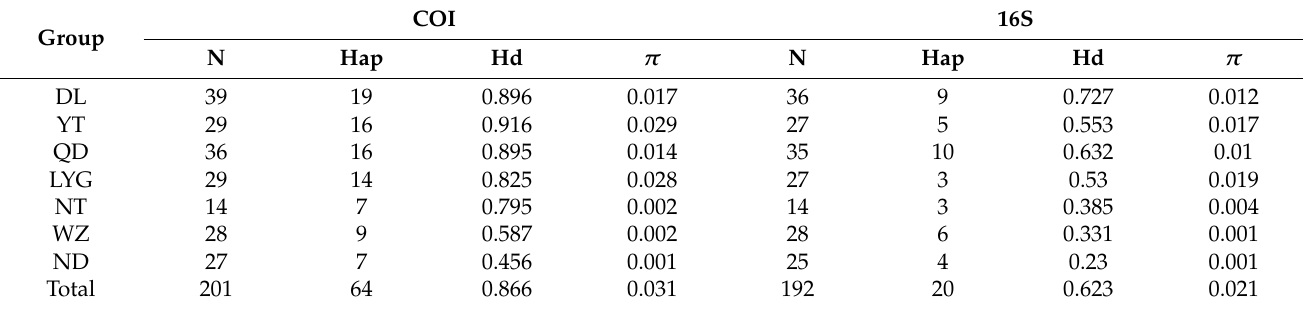
Table 1. The genetic diversity indices for geographic localities of L. ( N. ) beka